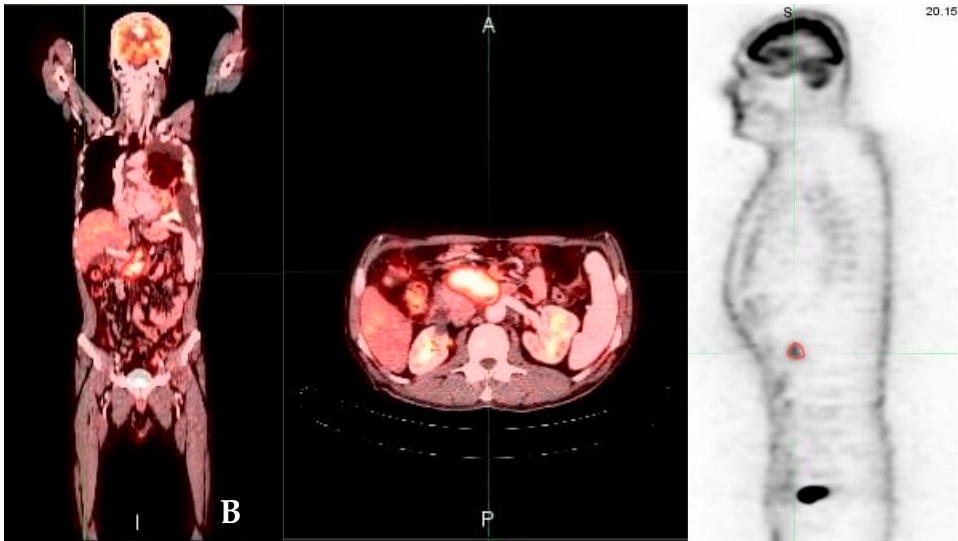
Figure 2. A 57-year-old man with pancreatic adenocarcinoma stage four. PET/CT scans performed at baseline reveal moderate metabolic activity (yellow regions, ( A , B ); maximum standardized uptake value, 6.6) consistent with primary pancreatic mass; projection of maximal intensity PET scan demonstrates 227 mL of tumor glycolytic activity with signs of metastatic involvement (pancreatic head mass with superior mesenteric lymph nodes and left parietal pleura of high metabolic activity).